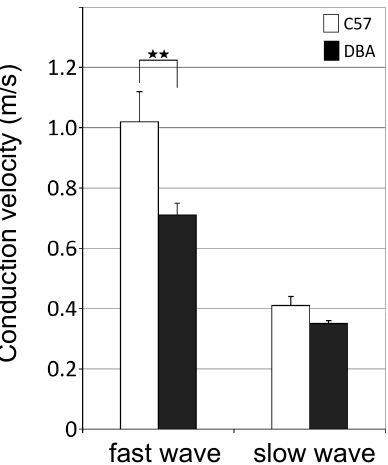
Figure 6. DBA mice show, in comparison with C57, reduced signal conduction velocity for fast, myelinated fibers in the corpus callosum. A significant difference in conduction velocity was observed for the fast wave between DBA and C57, as depicted. See Figure S2 for example trace of slow conducting fibers (slow wave) and fast conduction fibers (fast wave). Significant differences are represented by t -test (2-tailed) ** p < 0.01. C57, n = 4 (14 slices); DBA, n = 5 (11 slices).